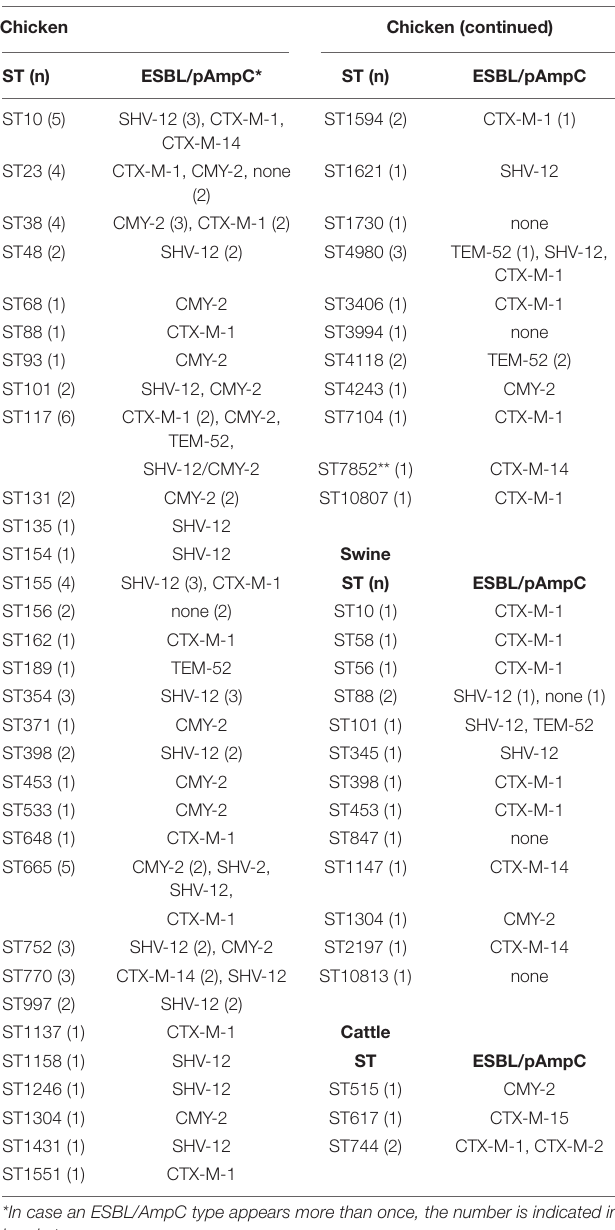
TABLE 4 | Multilocus sequence types and ESBL/AmpC types of 99 ESC-non-S/ESC-R Escherichia spp. from livestock